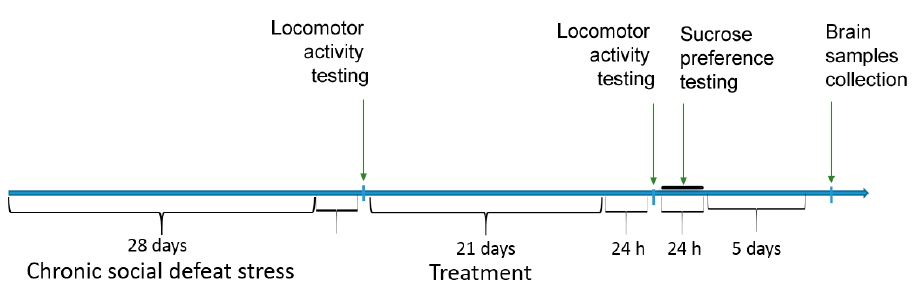
Figure 1. The design of the experiment the low-molecular-weight BDNF mimetic GSB-106 effects in a model of chronic social stress in mice.